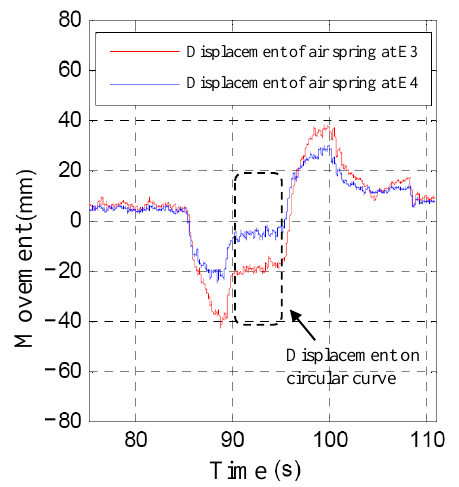
Figure 11. Displacement curve of air spring at E3 and